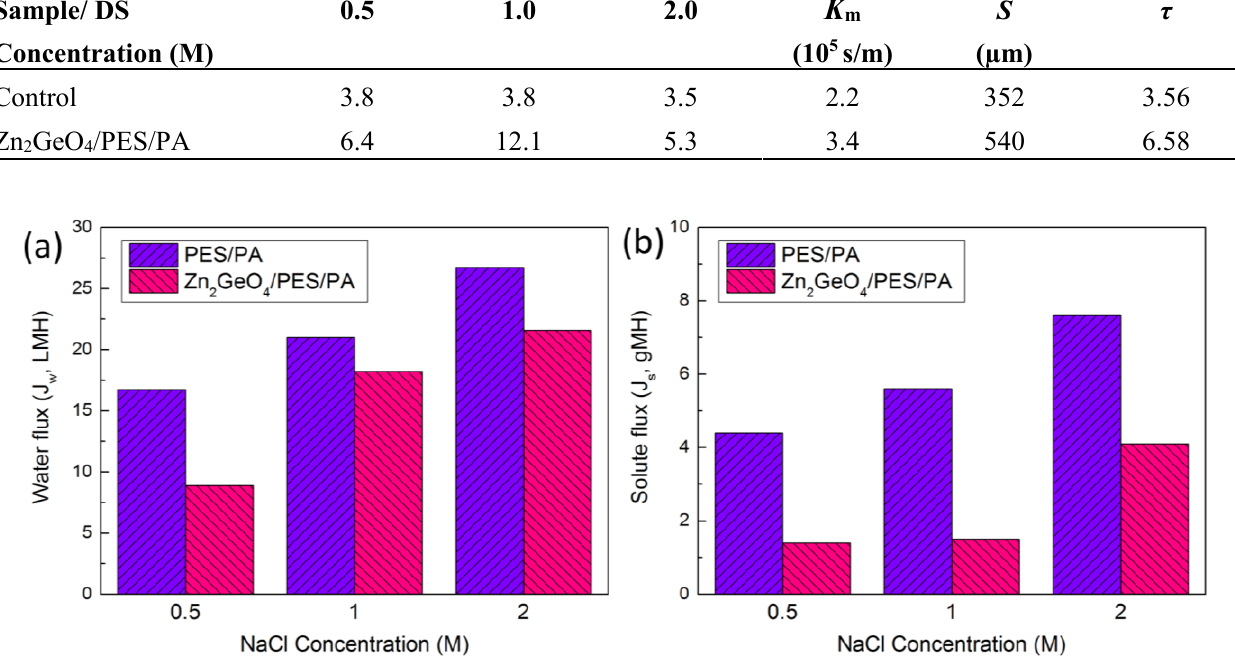
S τ (10 5 s/m) (µm)